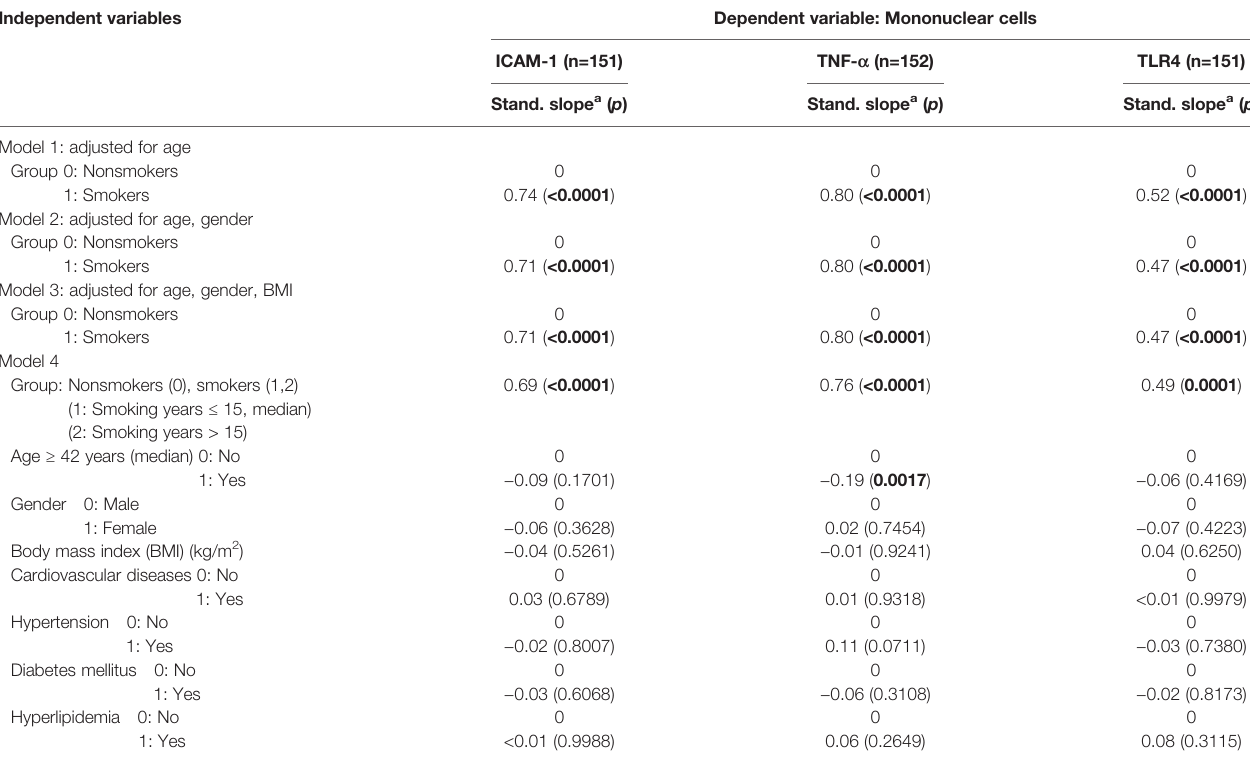
TABLE 4 | Multiple regression analysis of each main outcome-dependent variable for mononuclear cell markers (n = 159). Independent